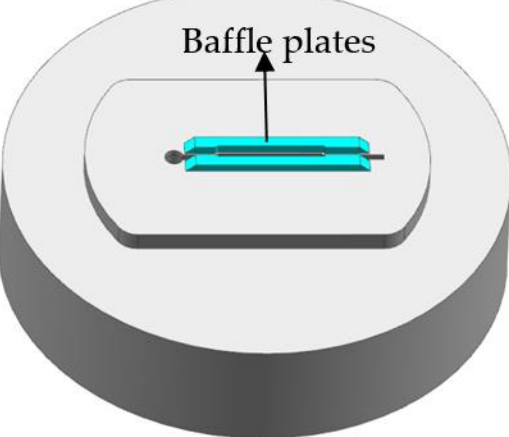
Figure 11. Location and shape of introducing the baffle plates.